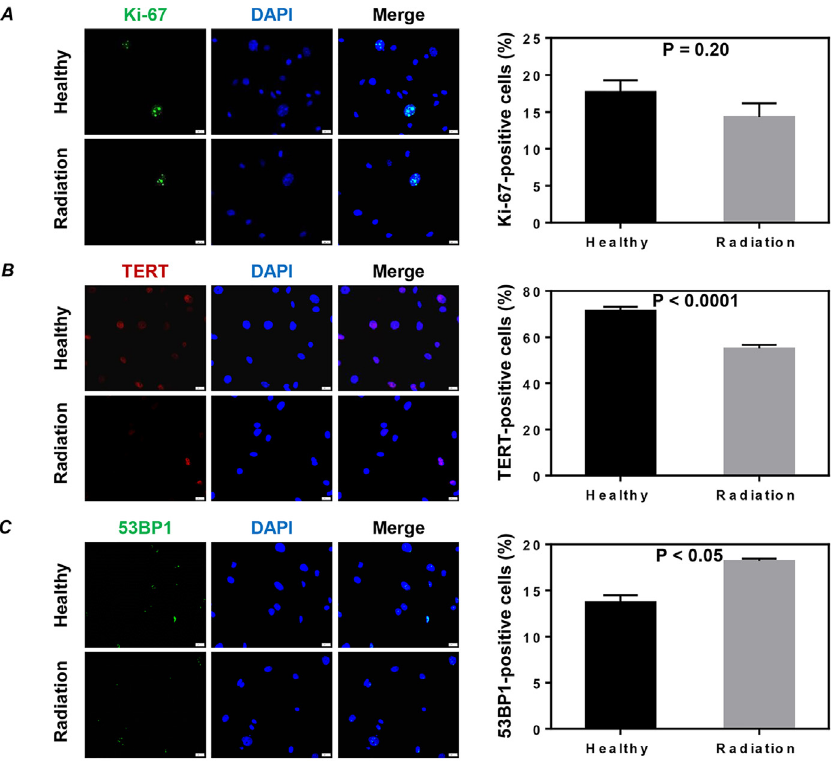
Fig 4. Proliferation, telomerase activity and DNA damage of cardiac stem cells (CSCs). The proliferation (A), telomerase activity (B) and DNA damage (C) of CSCs were evaluated by immunostaining with Ki-67, telomerase reverse transcriptase (TERT), and 53BP1, respectively. Representative images (left) and quantitative data (right) are shown. The nuclei were stained with DAPI. Scale bar: 20 μ m. Values shown are the mean ± SEM from 6 independent experiments in A and B and 3 independent experiments in